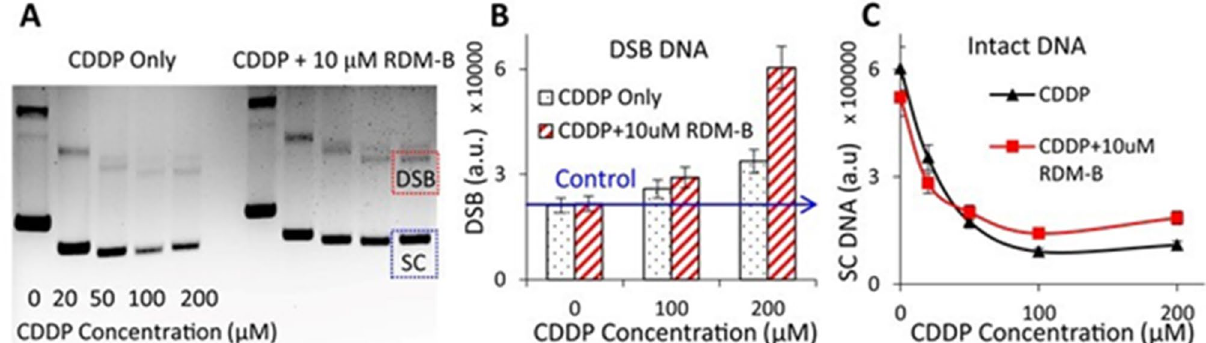
Figure 1. DNA damage measurements using agarose gel electrophoresis. ( A ) Gel images of plasmid DNA treated with various concentrations of CDDP with/without the presence of 10 μM RDM-B (BV10), where the three separate bands from top to bottom represent DNA with single-strand break (SSB), double-strand break (DSB, red dashed square), and intact supercoiled DNA (SC, blue dashed square). The yields of DSB DNA and the amount of SC DNA are shown in ( B ) and ( C ),